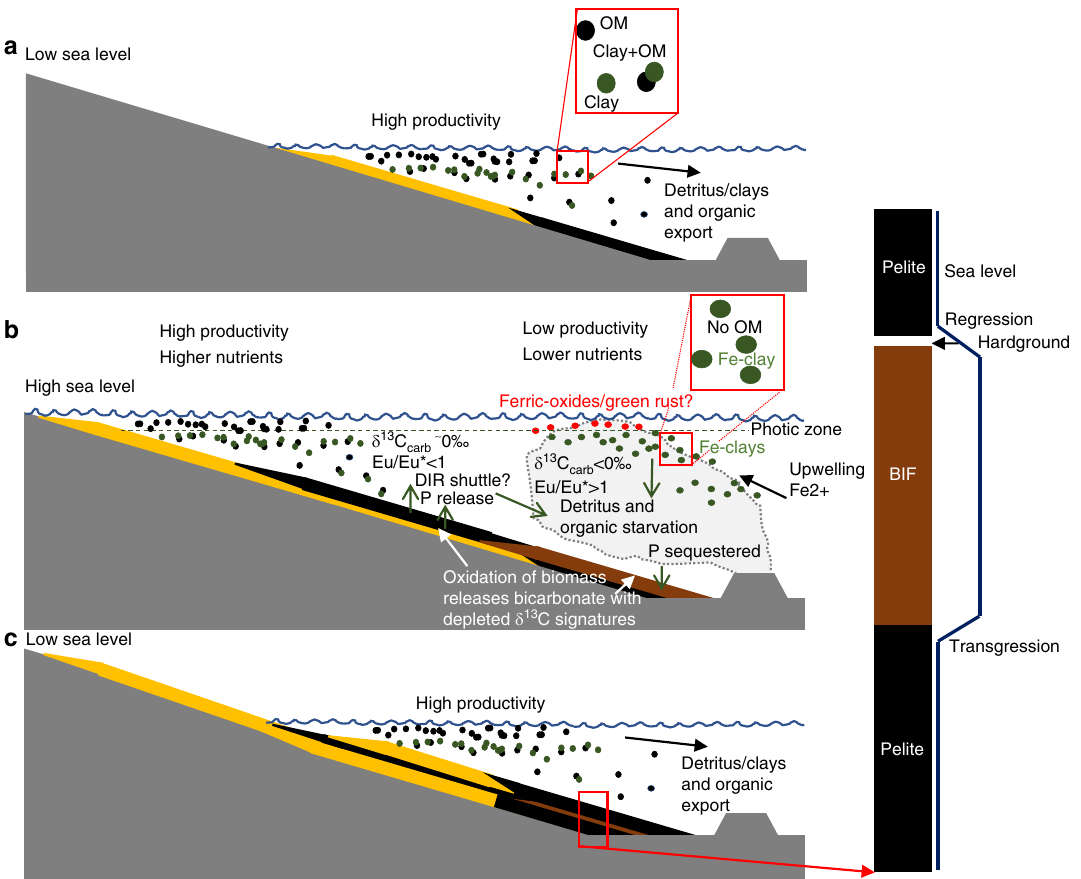
Fig. 8 Model for the deposition of BIF. a Low sea level allows extensive export of organic matter and detritus from shallow marine environments to far shelf, slope and abyssal environments. Organic matter and clays complex in the water column and are deposited in the sediments together which protects organic matter from oxidation. b Higher sea level reduces the export of organic matter from the shelf and starves the deeper basin of organic matter and detritus. Exhalation of hydrothermal fl uids leads to precipitation of various iron-rich minerals, Fe-clays precipitate during mixing of hydrothermal fl uids and seawater in a water column devoid of organic matter, therefore decoupling their deposition together in BIF precipitates. Small quantities of organic matter exported from shallow marine environments may be deposited and oxidised in conjunction with ferric iron reduction. c Following a hiatus in hydrothermal exhalations, hardgrounds form on the detritus starved sea fl oor. Sea level falls, returning plentiful organic matter and detritus export to deeper parts of the basin. Yellow layers represent shallow marine sediments, black layers represent shale, and brown represents